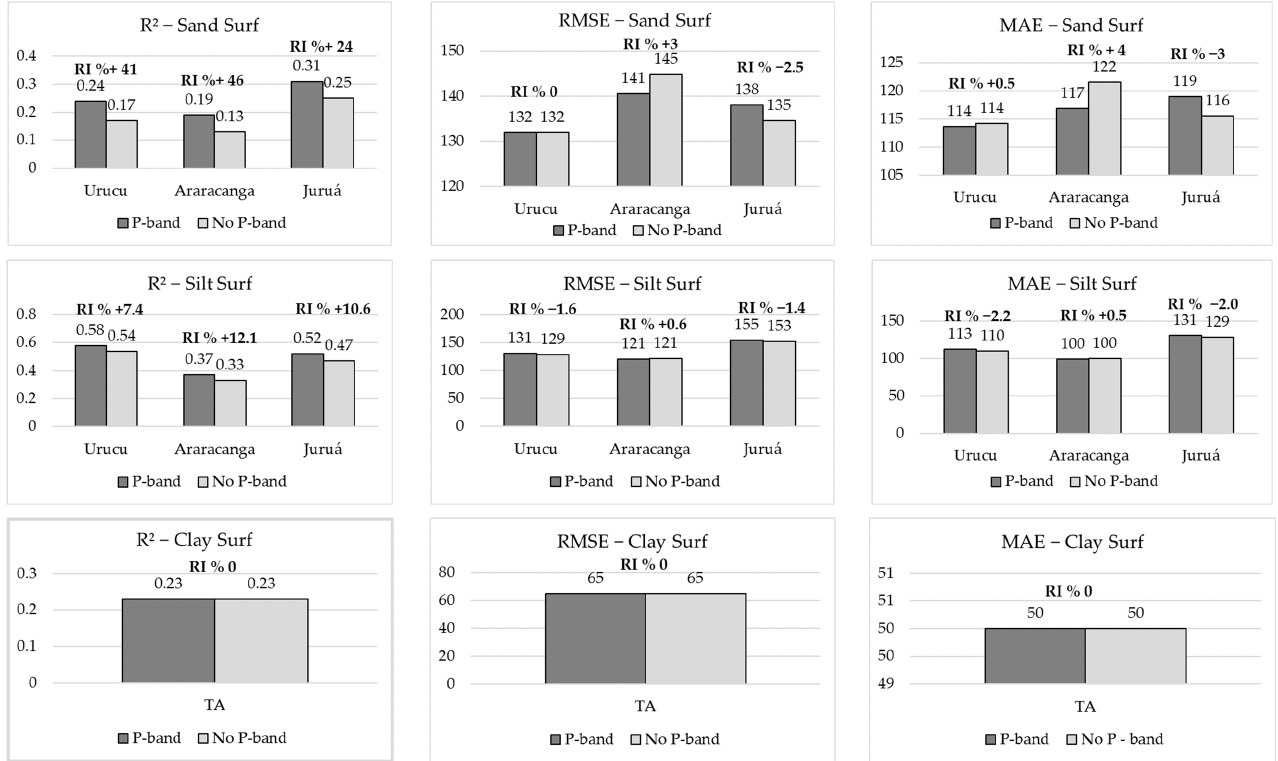
Figure 7. Accuracy with and without radar P-band for surface sand, silt, and clay prediction with the best model and approach.